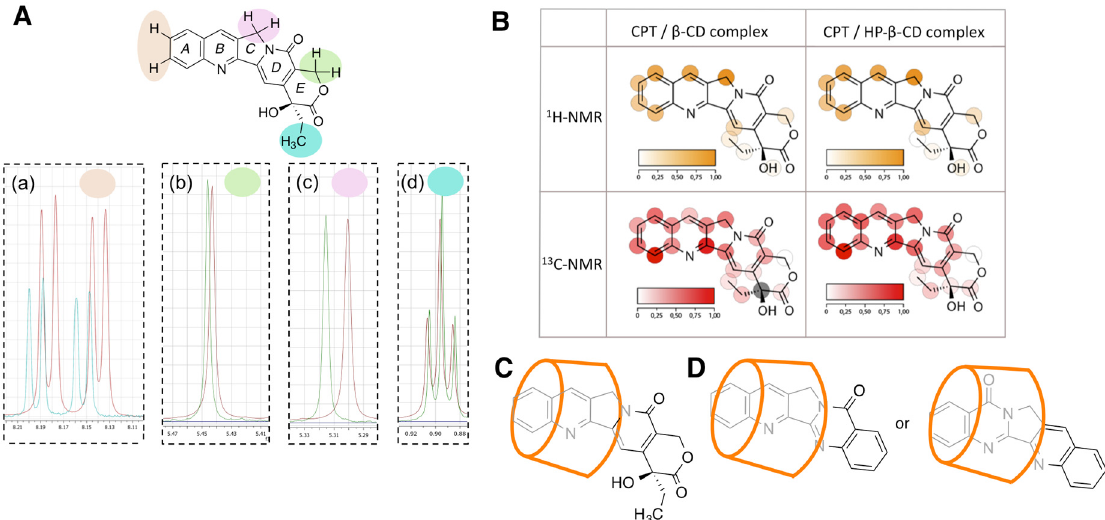
Figure 3. ( A ) Changes observed in selected signals of the camptothecin 1 H-NMR spectrum upon complexation with β - cyclodextrin, showing significant changes in the position of the signals in ( a ) and ( c ) and only slight changes in ( b ) and ( d ). ( B ) Normalized (0–1) chemical shift changes in the 1 H-NMR and 13 C-NMR spectra of camptothecin following complexation with β -cyclodextrin and hydroxypropyl- β -cyclodextrin. ( C ) Model of inclusion of camptothecin inside the β -CD cavity according to NMR data. ( D ) Two alternative models of inclusion of luotonin A inside the β -CD cavity according to NMR data.